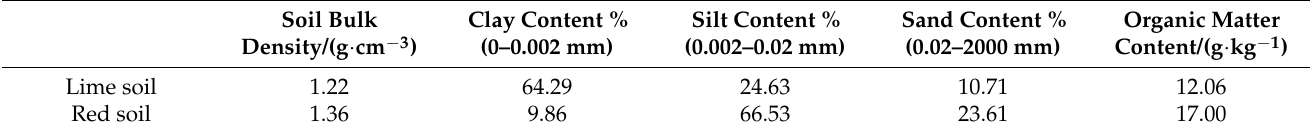
Table 1. Basic physical properties of the tested